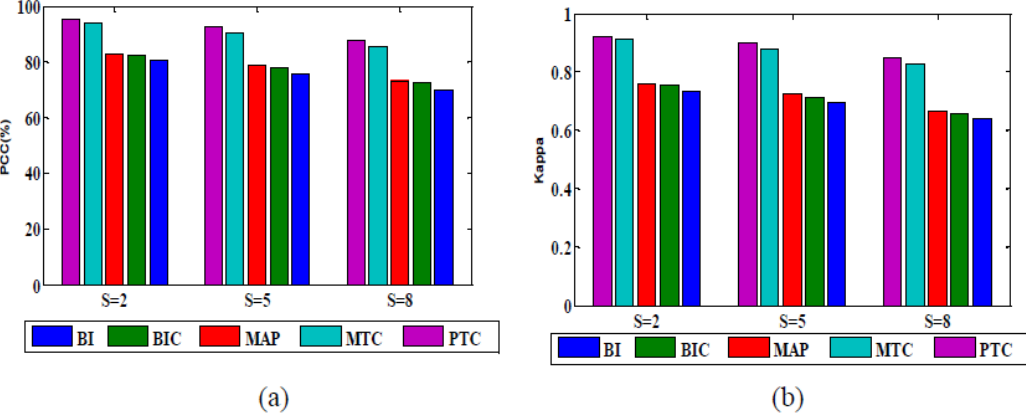
Figure 15. ( a ) PCC (%) of the five methods in relation to scale factor S ; ( b ) Kappa of the five methods in relation to scale factor S .